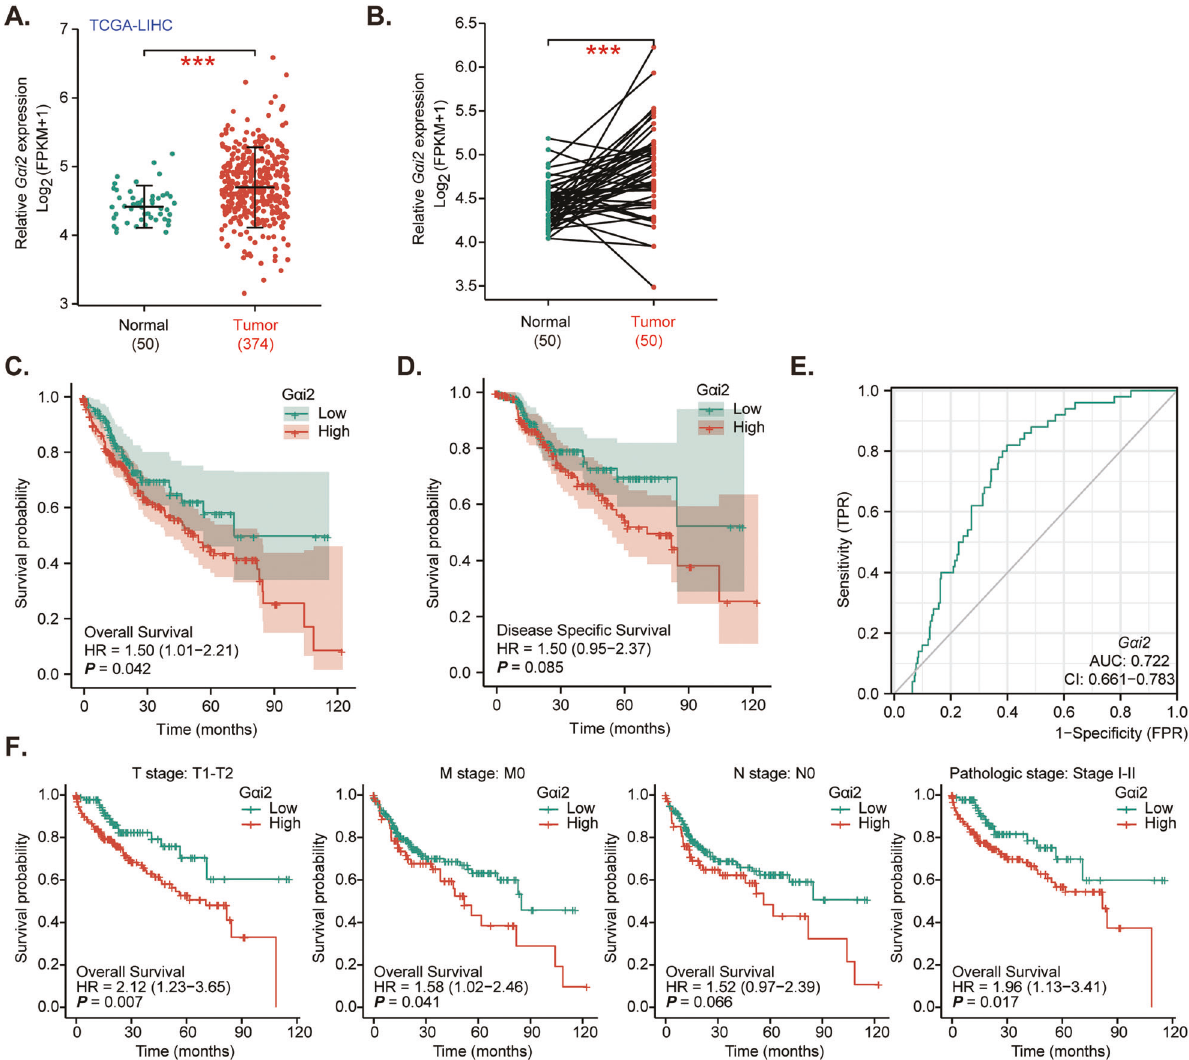
Fig. 1 G α i2 overexpression in HCC. The Cancer Genome Atlas Liver Hepatocellular Carcinoma (TCGA-LIHC) database shows G α i2 expression (RNA-Seq) in HCC tissues ( “ Tumor ” , n = 374) and normal liver tissues ( “ Normal ” , n = 50) ( A ). TCGA-LIHC shows G α i2 expression in HCC tissues ( “ Tumor ” , n = 50) and matched adjacent normal liver tissues ( “ Normal ” , n = 50) ( B ). The Kaplan – Meier Survival analyses of overall survival ( C ) and disease free survival (DSS, D ) of G α i2 -low (in green) and G α i2 -high (in red) HCC patients from TCGA-LIHC. The receiver operating characteristic (ROC) curve showed the relationship between G α i2 overexpression and the potential predictive value on HCC patients ’ overall survival ( E ). The subgroup analyses of G α i2 expression (RNA-Seq) and overall survival in the listed HCC patients were shown ( F ). “ TPM ” stands for transcripts per million. “ AUC ” stands for area under curve. “ CI ” stands for con fi dence interval. “ HR ” stands for hazard rate. “ TPR ” stands for true positive rate. “ FPR ” stands for false positive rate.*** P < 0.001 ( A , B